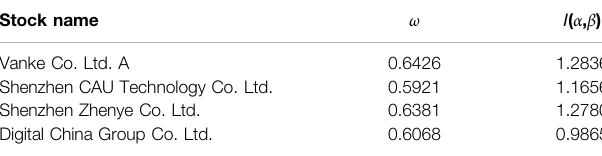
TABLE 5 | Parameters obtained for the two layered networks for different combinations of Ping An Bank Co. and four different stocks. Stock